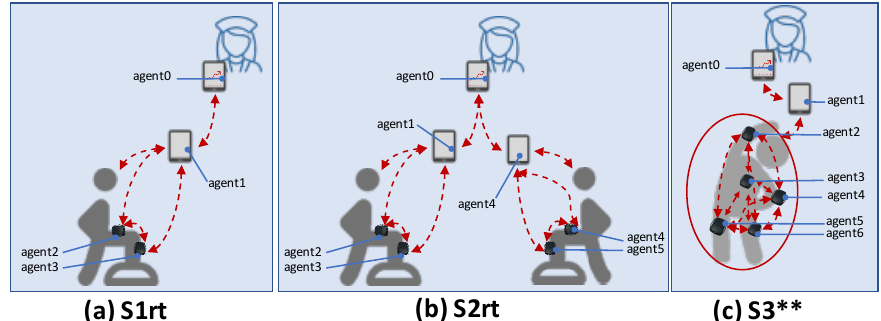
Figure 8. Simulated configurations for S1, S2 and S3. S1 represents a single patient multi-agent scenario, S2 a simultaneous two-patient scenario, and S3 a multi-agent scenario with multiple coordinating body-sensors.